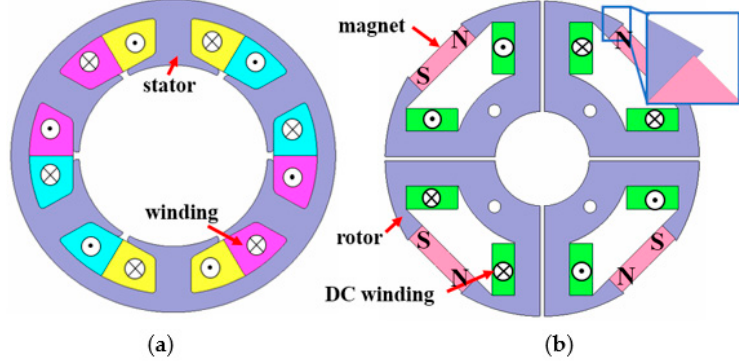
Figure 2. Topology of the proposed model: ( a ) Stator; ( b ) Proposed rotor.